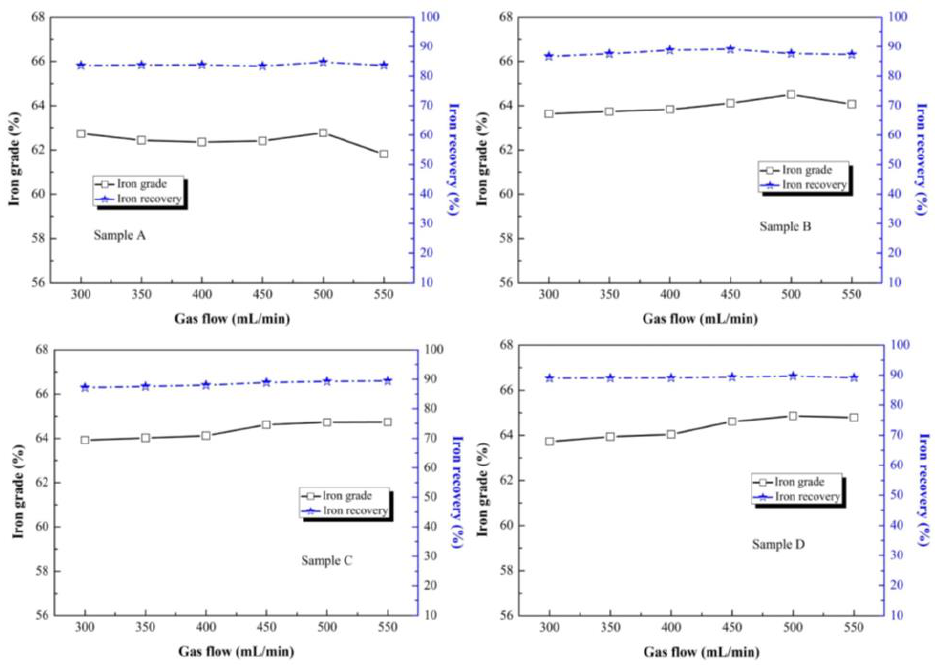
Figure 12. The iron grade and iron recovery of sample A to D with different gas flows.